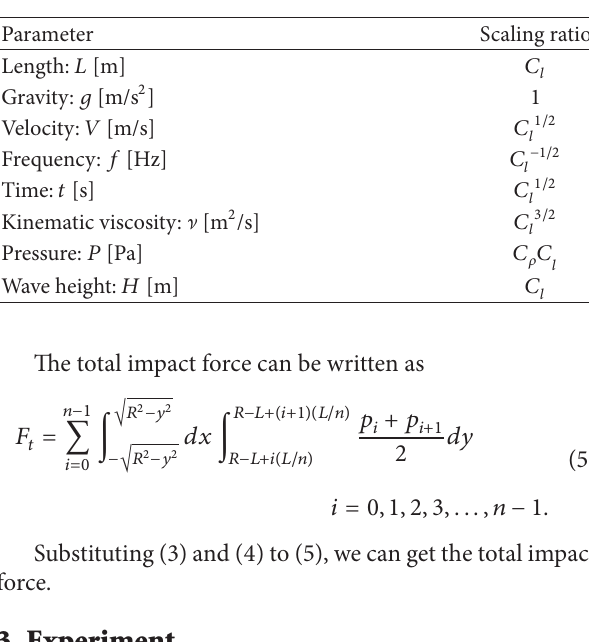
Table 1: Scaling factors for sloshing experiments.